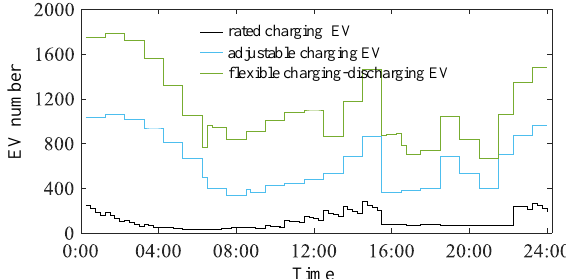
Figure A1. Solar power and wind power.